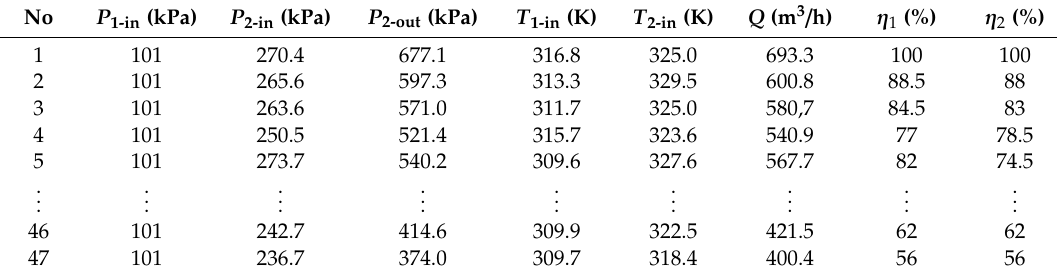
Table 5. Part of the training and test